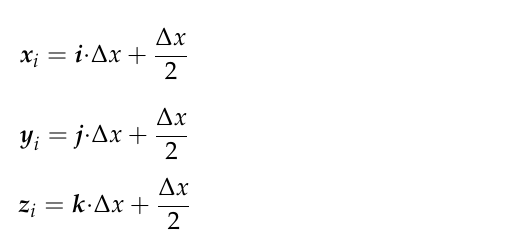
Figure 5. Calculation model of the CCMTT: ( a ) i-j coordinate system and ( b ) i-k coordinate system.